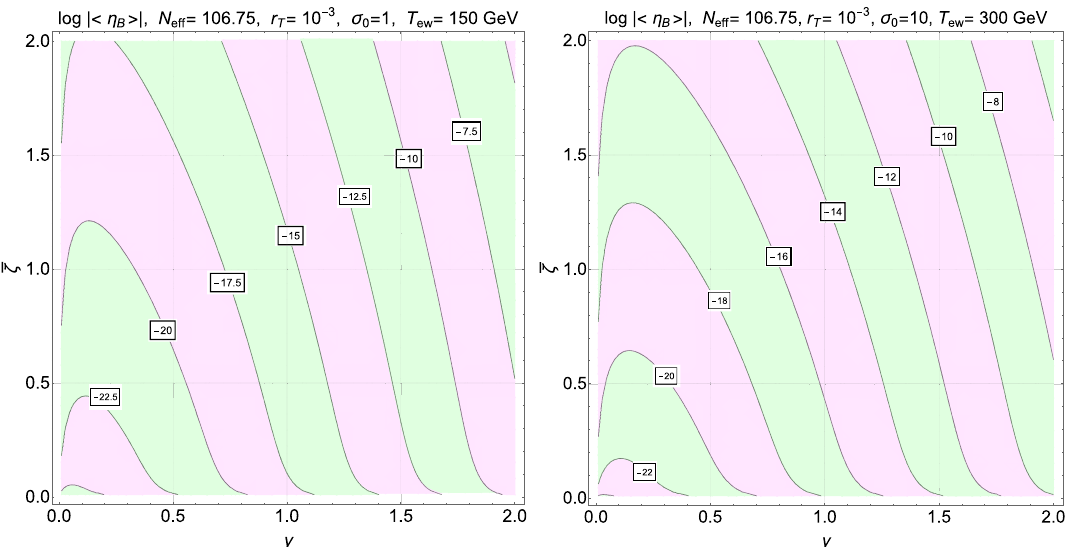
Fig. 4 We illustrate the contours of the common logarithm of the BAU for larger values of T e w (i.e. T e w = 150GeV and T e w = 300GeV) and for two extreme values of σ